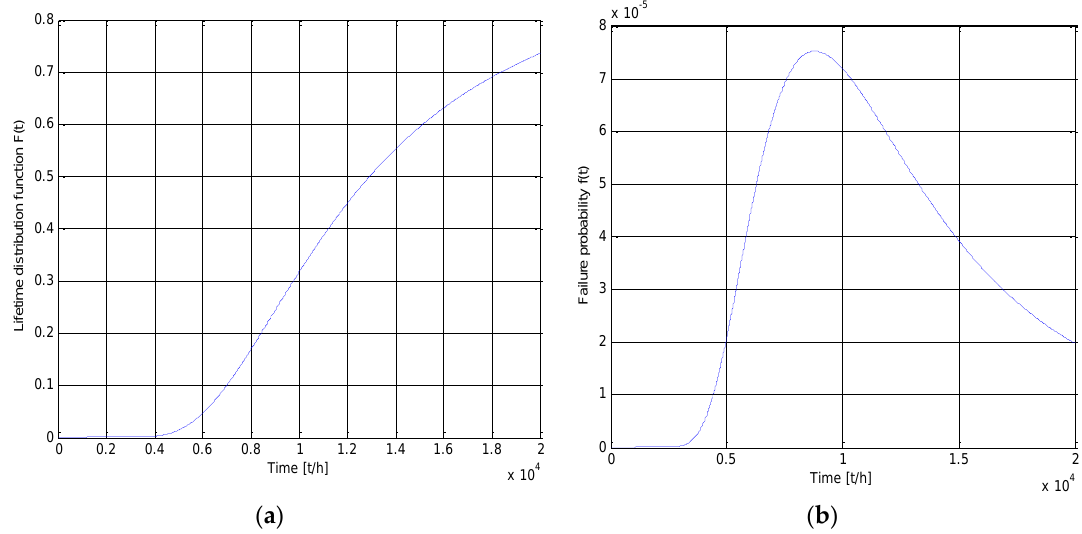
Figure 3. ( a ) Distribution function of bearing life; ( b ) probability density function (PDF) of bearing life.